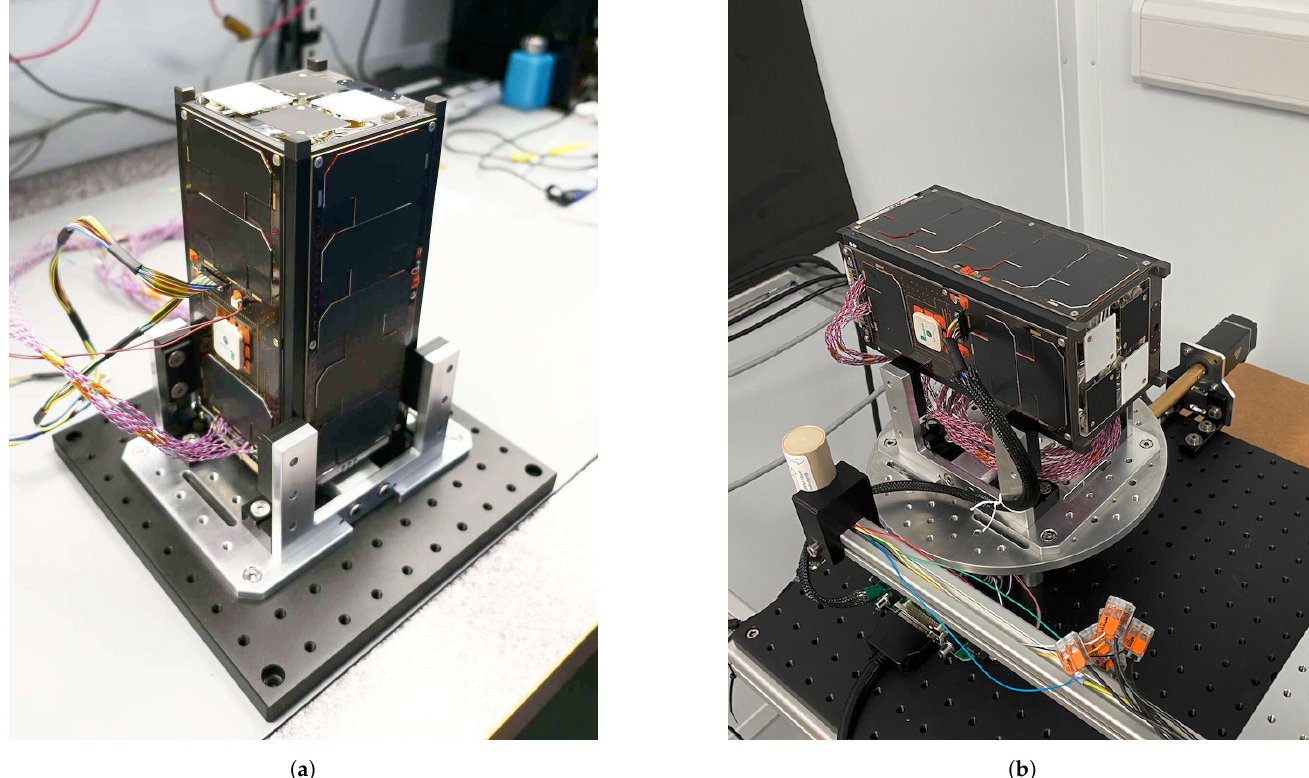
Figure 5. EIRSAT-1 EQM system configuration for the FFT campaign. ( a ) EQM setup in the integration stand. ( b ) EQM setup in the attitude determination and control system (ADCS) turntable